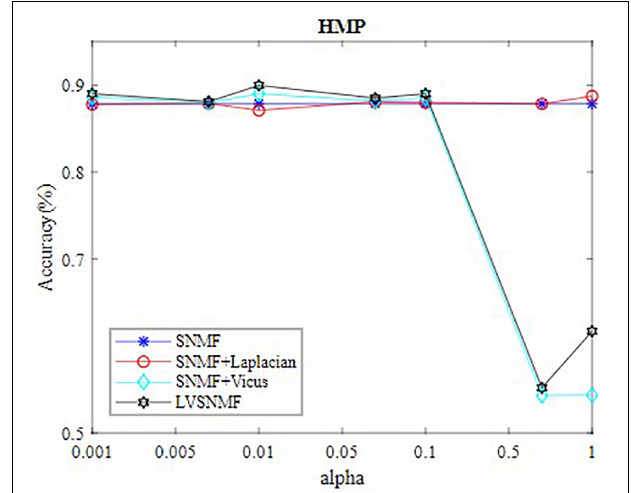
FIGURE 2 | The best performance of LVSNMF as α increases.